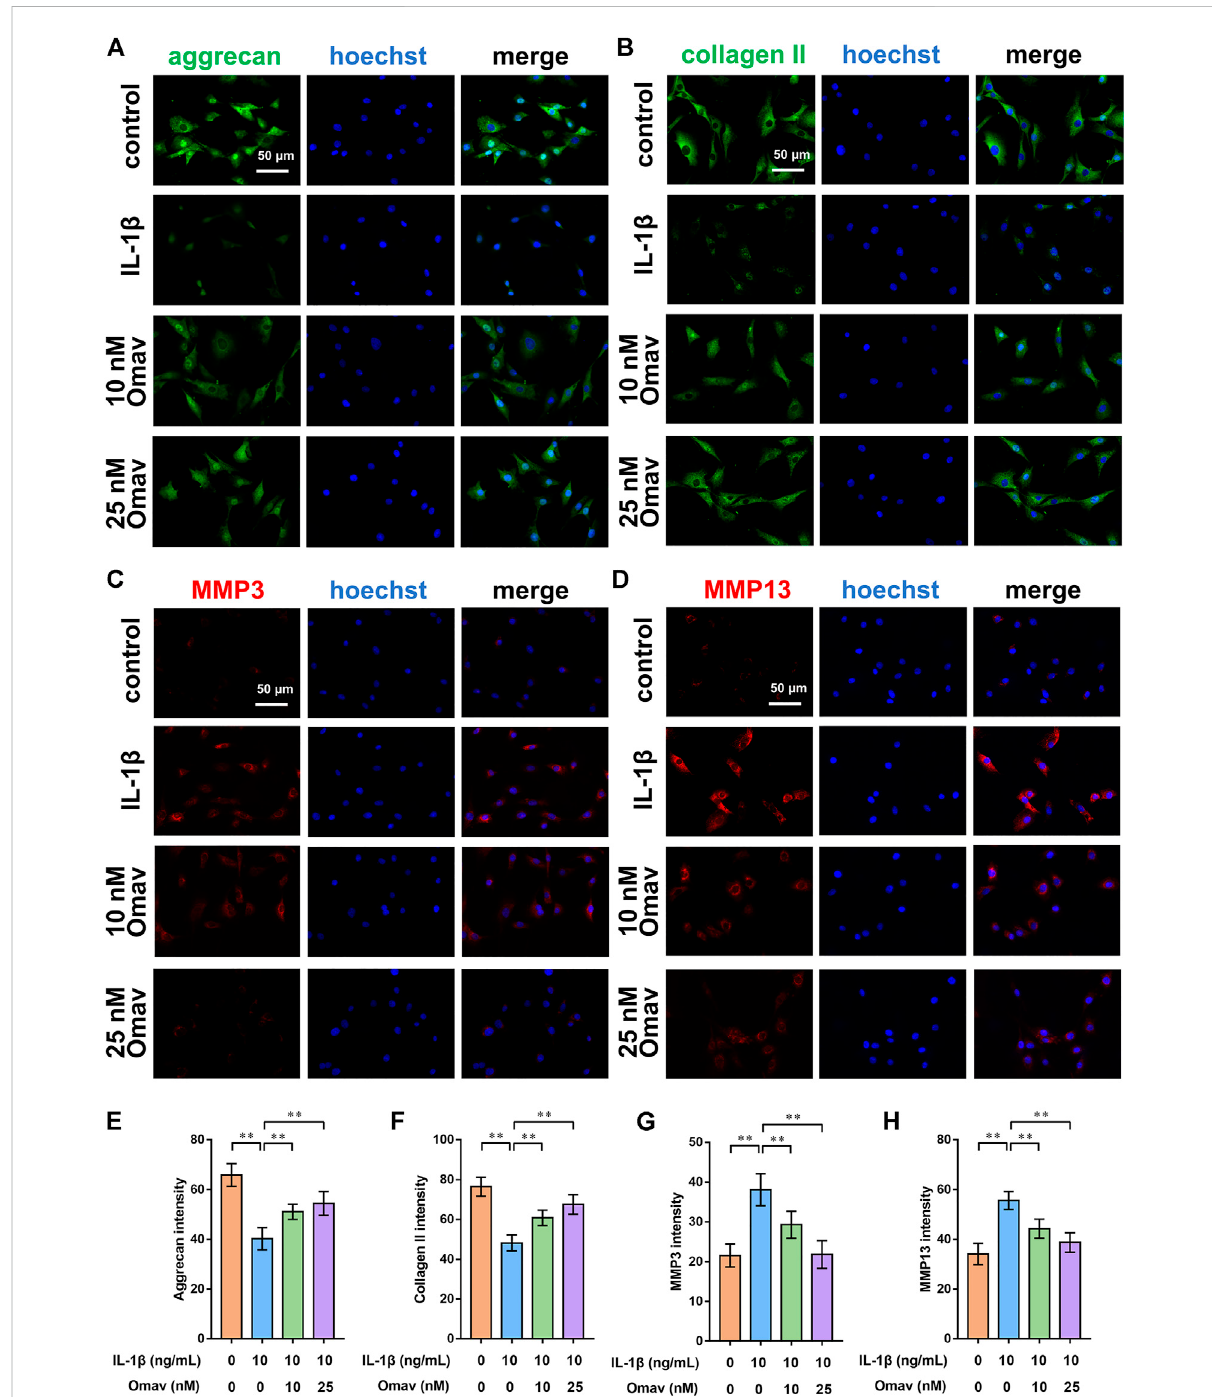
Omaveloxolone suppressed IL-1 β -induced ECM degradation in vitro . Representative immuno fl uorescence images of aggrecan (A) , collagen type II (B) , MMP3 (C) and MMP13 (D) (scale bar, 50 μ m). The results of the quantitative analysis showed that omaveloxolone enhanced aggrecan (E) andcollagentypeII (F) proteinexpressionwhileinhibitingMMP3 (G) andMMP13 (H) proteinexpressioninchondrocytesexposedtoIL-1 β .** p <